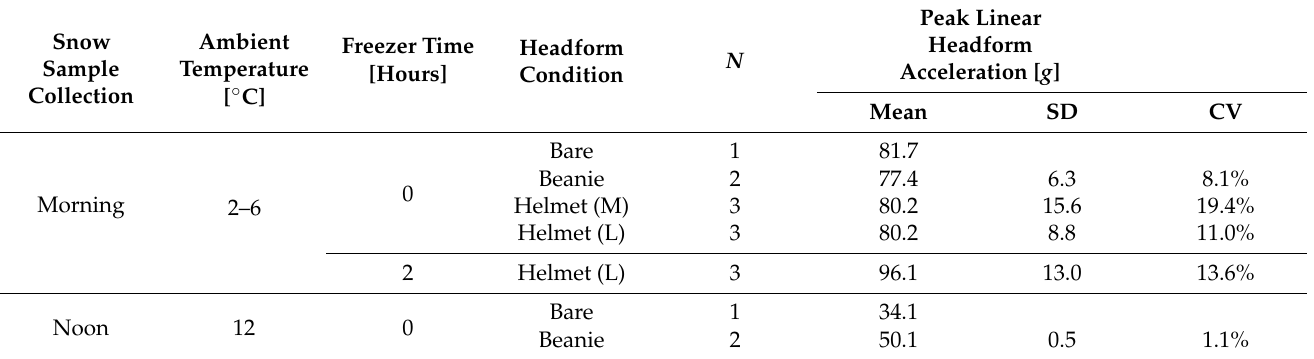
Table 1. Peak linear headform accelerations for vertical drop tests from 0.85 m onto snow samples.